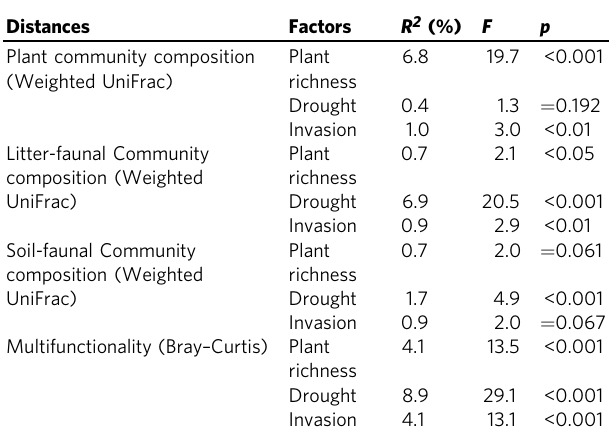
Fig. 1 Hypotheses and experimental design. a Plant richness increases ecosystem multifunctional stability (Hypothesis 1). b Drought/invasion decrease multifunctional stability (invariability and resistance to invasion/drought) (Hypothesis 2). c Plant, litter-, and soil-faunal communities mediate the effects of plant species, drought and invasion on ecosystem multifunctional stability (Hypothesis 3). d With the species pool consisting of 16 plant species, the monoculture of each species, and the random mixtures of 2, 4, and 8 species (with 10, 10, and 9 distinct assemblages, respectively) were designed, creating a complete set of 45 distinct plant assemblages. e Each plant assemblage was replicated 6 times, for a total of 270 assemblages (pots). After 1-year of growth the assemblages were manipulated with three levels of drought intensities (non-, moderate-, and intensive-drought). Nine months after the introduction of drought stress, 2 complete sets (45 pots) of each drought treatment we randomly exposed (invasion) or not exposed (non-invasion) to the invasive species Symphyotrichum subulatum . f Experiment schedules. # Litter sampling for litter-fauna extraction. ## Plant sampling for collecting aboveground/belowground plant biomass, and plant community data; Soil sampling for extracting soil-fauna, determining contents of soil organic carbon, nitrogen, phosphorus, and glomalin related soil protein (GRSP), or measuring activities of soil enzymes including β -glucosidase, protease, nitrate reductase, and dehydrogenase; Light interception ef fi ciency was determined monthly from May to August. ### Litterbags sampling for litter decomposition rate evaluation. Table 1 Permutational multivariate analysis of variance (PERMANOVA) showing the effects of plant richness, drought, and invasion on communities and